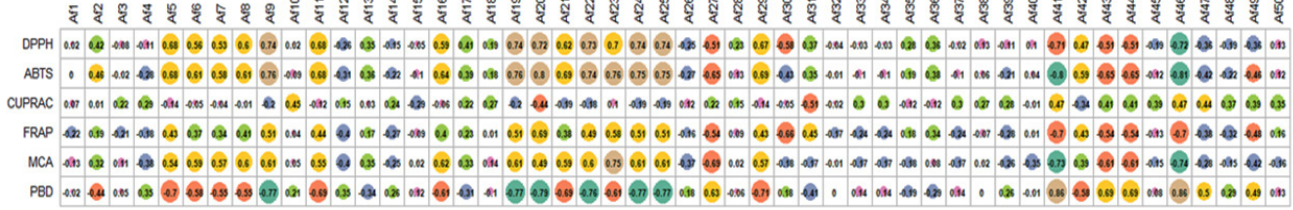
Figure 3. Relationship between secondary metabolites and antioxidant activities of Alcea fasciculiflora. For compounds numbers refer to Table 1. The correlation is considered positive and statistically significant (r >